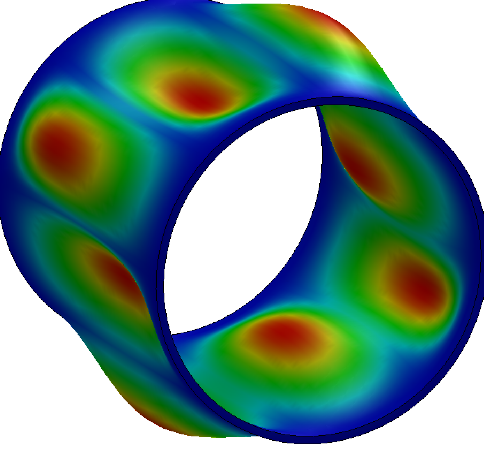
Figure 10. Optimized cylinder first buckling mode using